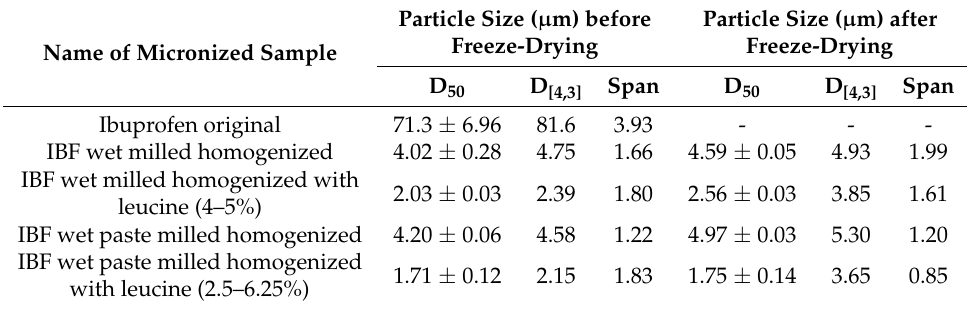
Table 2. Micronized IBF particle size determination by Malvern Mastersizer 3000 before and after freeze-drying (data provided as Mean ± SD, n =